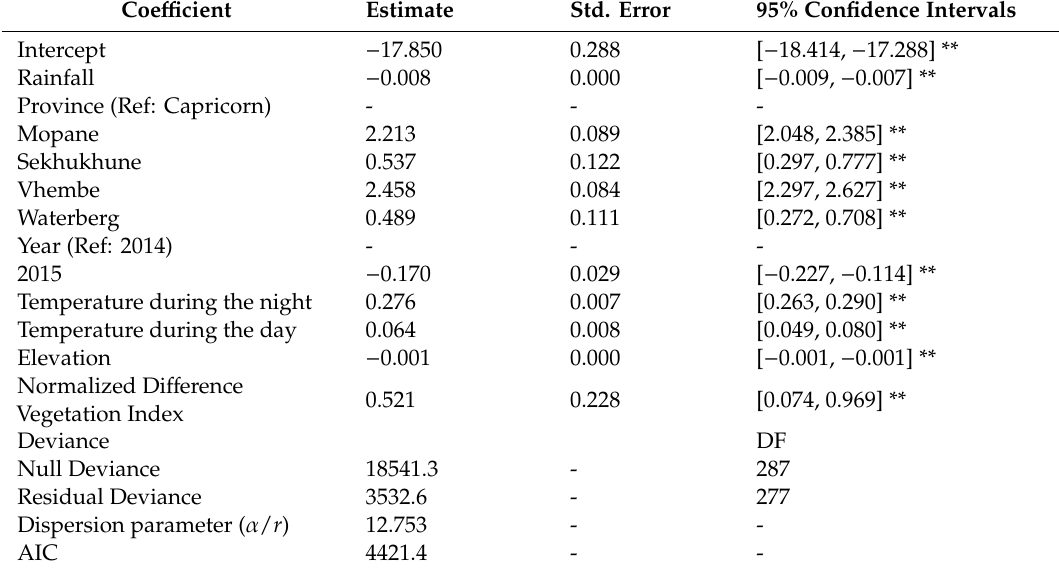
Table 3. Parameter estimates for Poisson regression model under classical approach encompassing all the